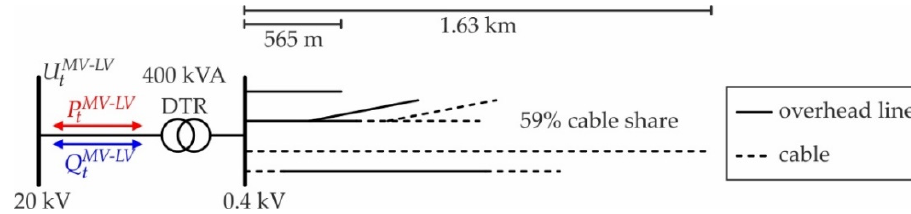
Figure 8. Simplified one-line diagram of the rural LV grid.